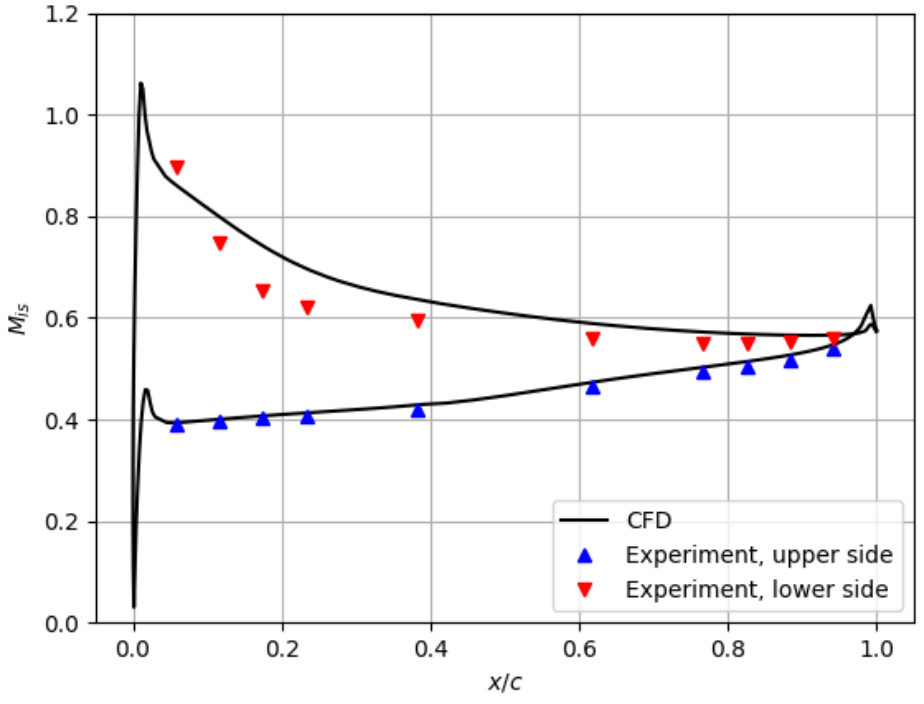
Figure 16. Isentropic Mach number distribution along the middle blade (blade no. 3) for α = −